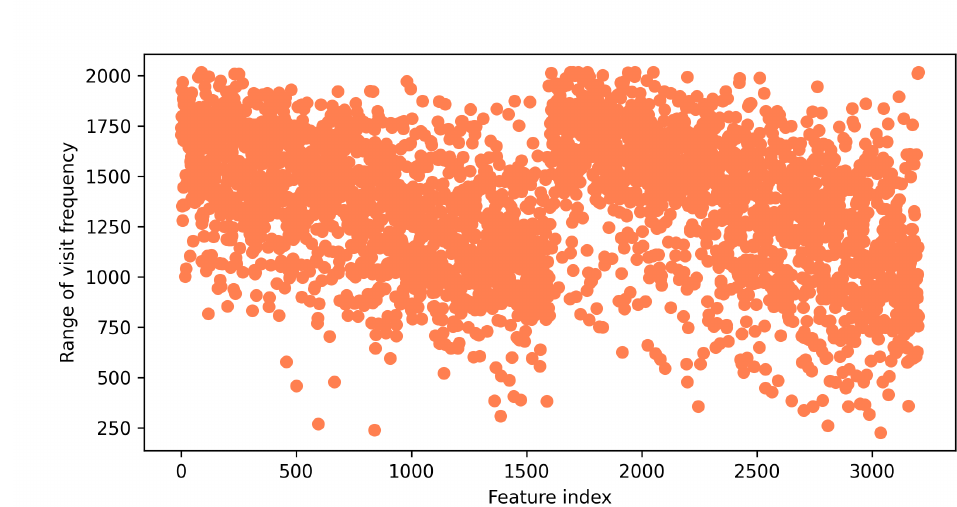
Figure 3. The distribution of travel-frequency patterns in long-term mobility